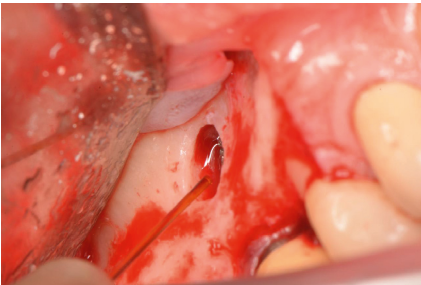
Figure 16: An Er,Cr:YSGG laser with the radially firing peri- odontal tip used to decontaminate the implant surface.